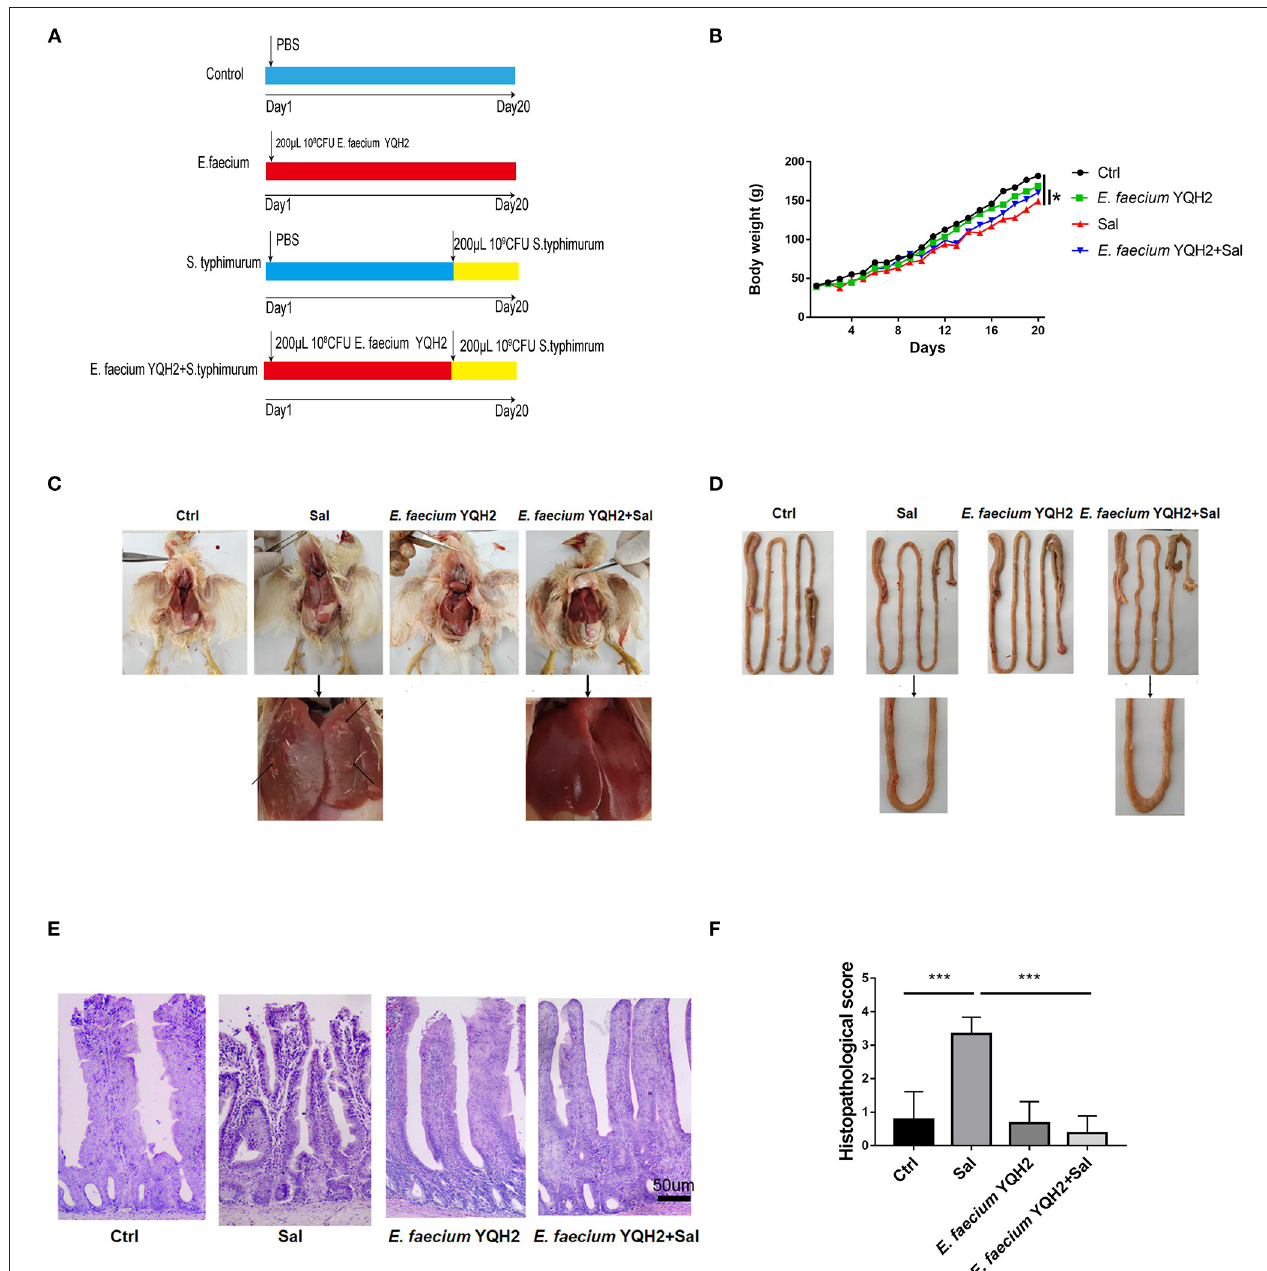
FIGURE 1 | Enterococcus faecium YQH2 obviously alleviated the histopathologic changes caused by S. typhimurium . (A) Broilers were orally administered with 200 µ l PBS in control group or 200 µ l 10 8 CFU of E. faecium in YQH2 group for a consecutive period of 20 days. Chickens of S. typhimurium group were orally administered with 10 9 CFU S. typhimurium on the 14th day. Chickens of YQH2 + S . typhimurium group were orally administered with 10 8 CFU E. faecium for 20 consecutive days and orally administered with 10 9 CFU S. typhimurium on the 14th day. (B) Changes in body weight of each group of broilers within 20 days, n = 8. (C,D) Apparent pathological changes in the liver and intestinal of chickens in four groups. (E) H&E staining of ileums in different groups (scale bar = 50 µ m), n = 6. (F) The histopathological score of the ileum in different groups according to the reference standard of pathology score, n = 6. * p < 0.05, ** p < 0.01, *** p < 0.001.